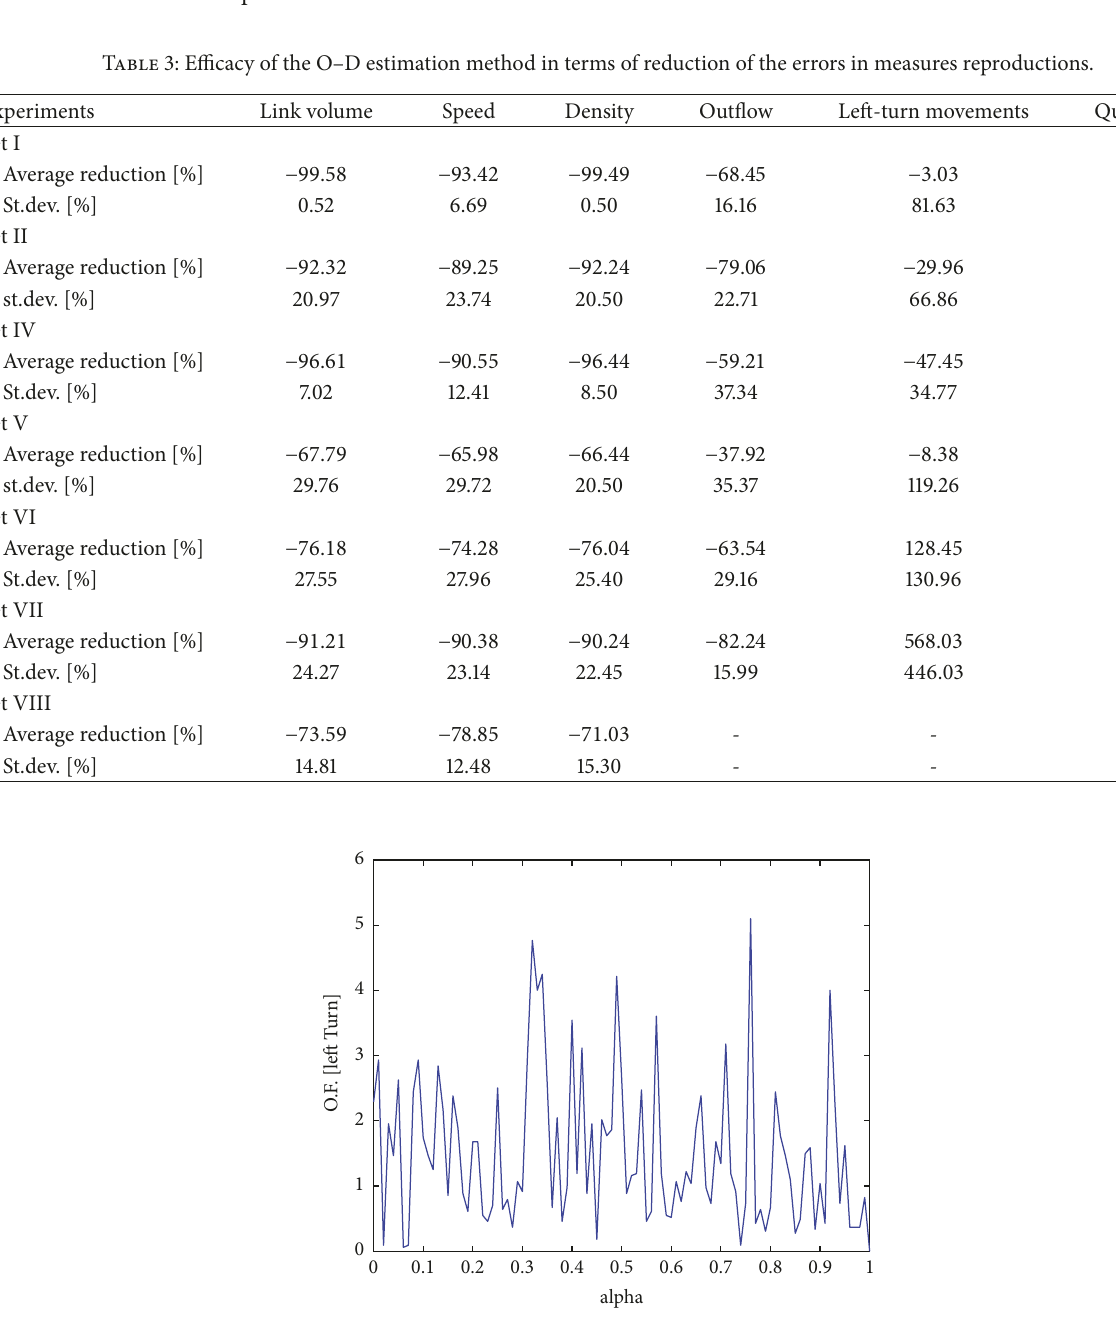
Figure 6: Left-turn error index scan for